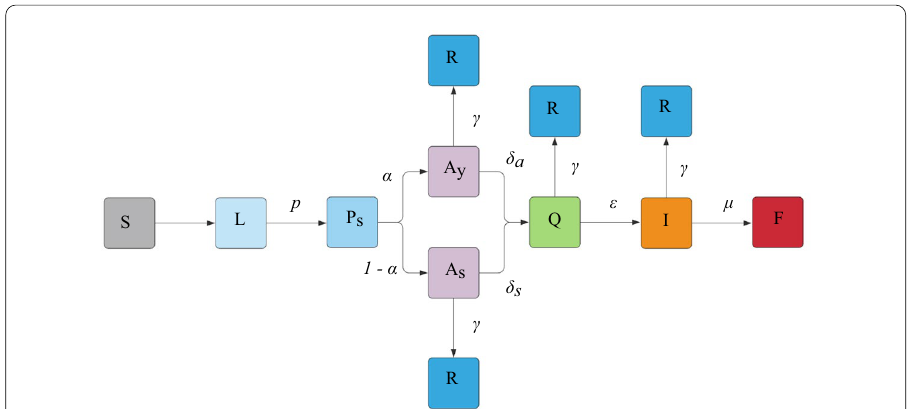
Fig. 3 Flow diagram demonstrating states